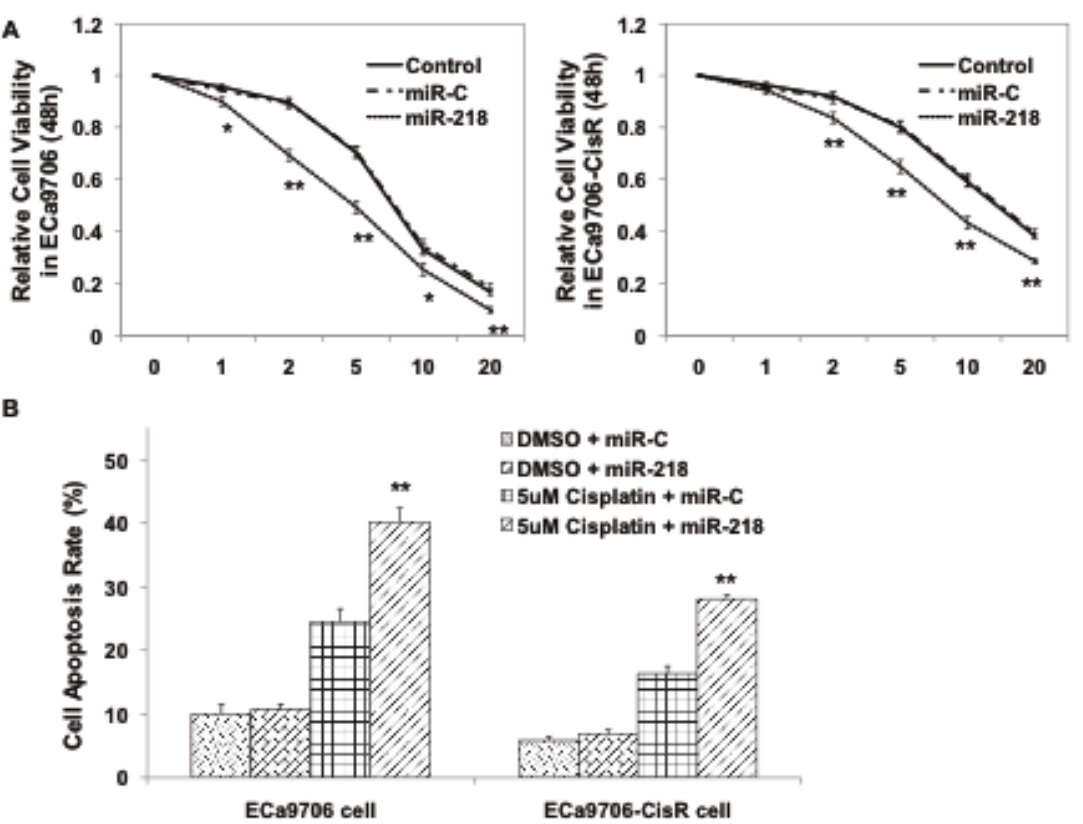
Figure 2. miR-218 enhances cisplatin sensitivity in both Eca9706 and ECa9706-CisR cells. (A) Cells were transfected with either control miRNA or miR-218 mimics. Then cells were treated with increasing doses of cisplatin (0, 1, 2, 5, 10 and 20 m M). 48h later, MTT assay was per- formed. (B) Overexpression of miR-218 increased apoptosis rate when treated with 5 m M cisplatin in both Eca9706 and ECa9706-CisR cells. *: P<0.05, **: P<0.01.